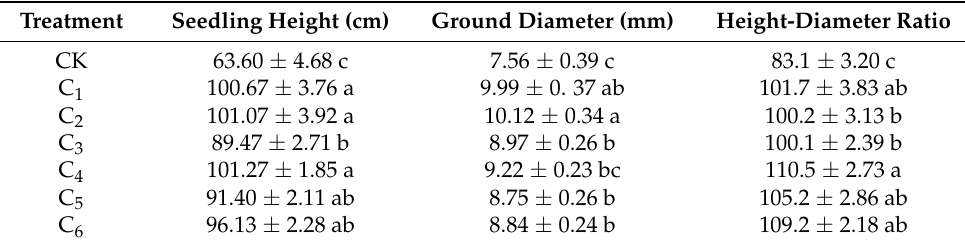
Table 2. The seedling height, ground diameter, and height–diameter ratio of S. sebiferum container seedlings in different biochar treatments.